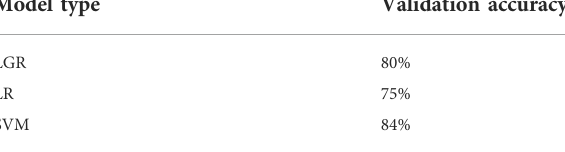
TABLE 5 Validation results of Machine Learning